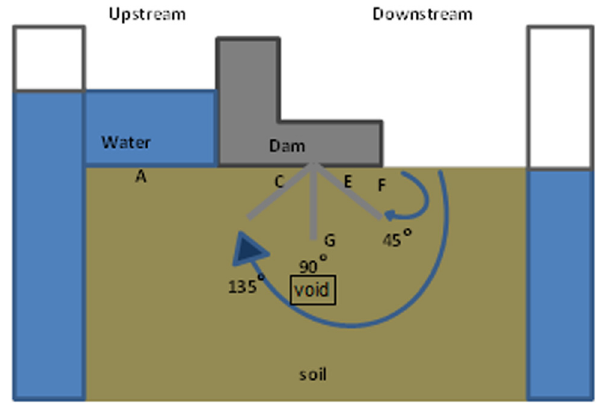
Figure 3: A diagram of the piezometers and